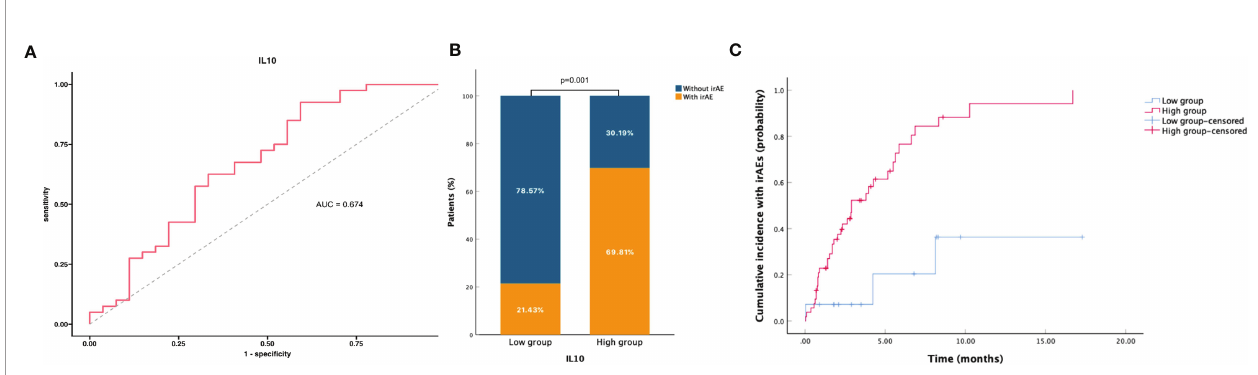
FIGURE 2 | Association between baseline blood IL-10 and irAEs. (A) ROC curve analysis of IL-10 and irAEs, AUC = 0.674. (B) The probability of occurrence of IrAEs in patients with low IL-10 and high IL-10. (C) Accumulative incidence of irAEs with patients during ICI therapy. Patients who died or have missing follow-ups were de fi ned as censored values. ROC, receiver operating characteristic; AUC, area under the curve; irAEs, immune-related adverse events; ICI, immune checkpoint inhibitor.